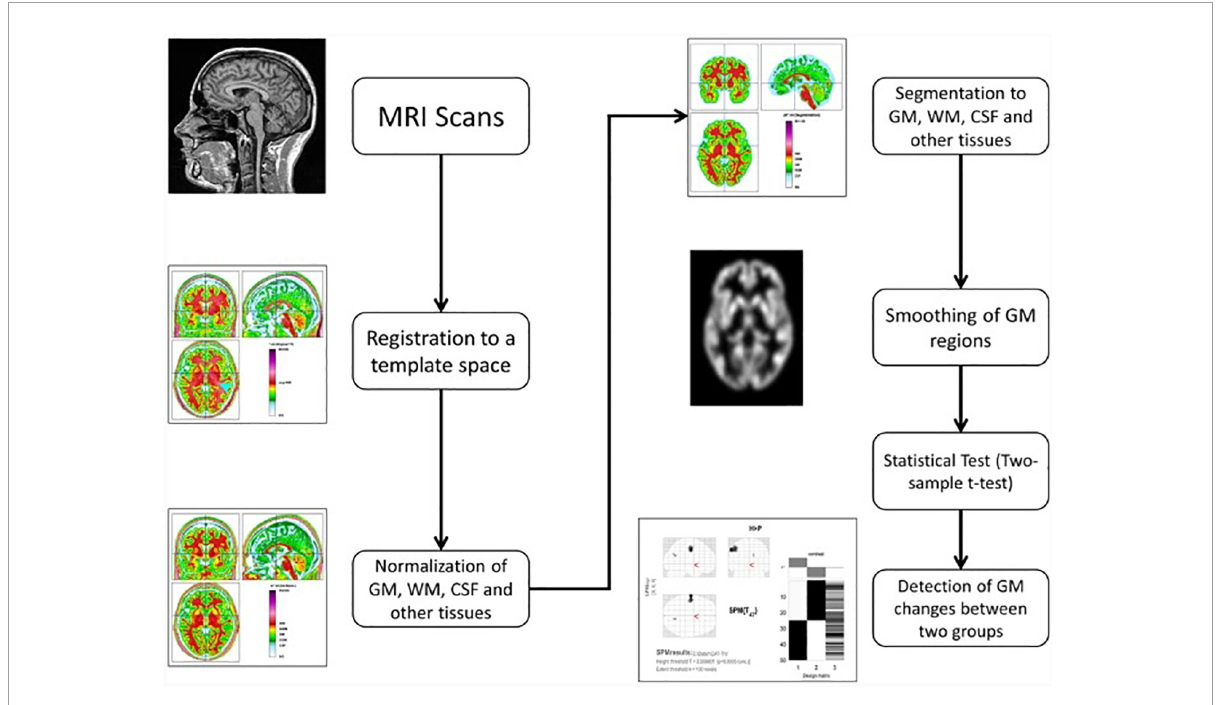
FIGURE3 The processing framework of voxel-based morphometry (VBM) analysis using the CAT12 toolbox of SPM12 software as depicted by Seyedi et al.